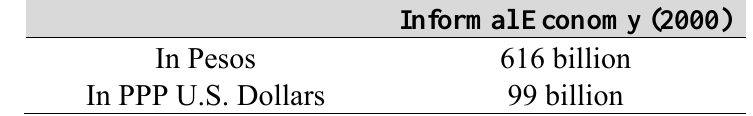
Table 3. Reported value of the Informal Economy estimate of